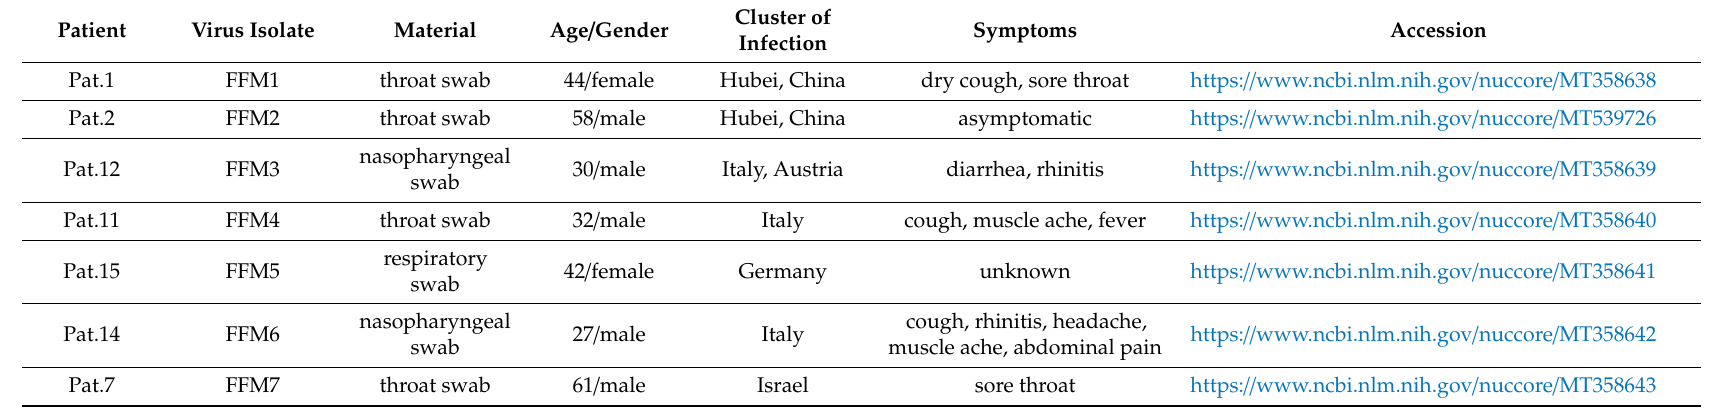
Table 2. Compilation of patient samples and isolated viral isolates in this